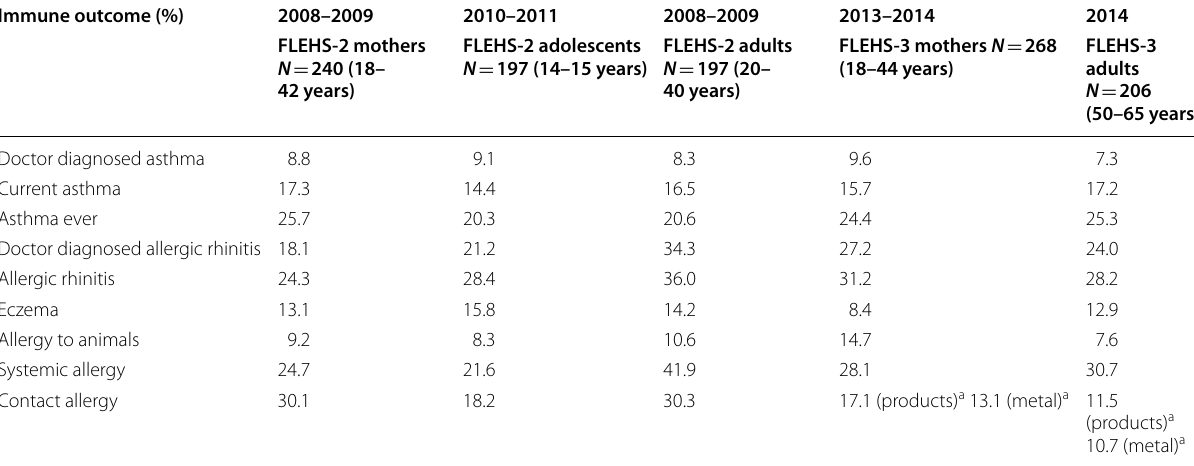
Table 2 Descriptive statistics of percentage of participants with immune-related disease outcomes in the different FLEHS-2 and FLEHS-3